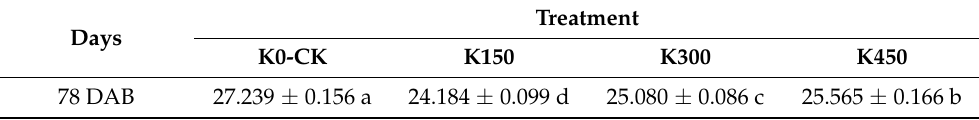
Table 3. Soil potassium content (mg · g − 1 ).